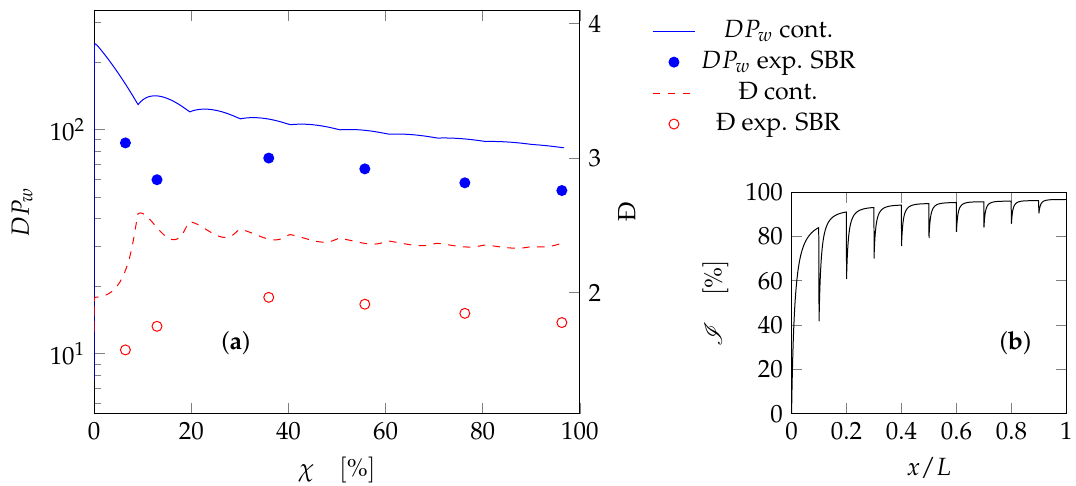
Figure 11. Series of N d = 10 PFRs with intermediate feed streams: ( a ) weight-average degree of polymerization ( DP w ) and polydispersity (Ð) as a function of the monomer overall conversion; ( b ) instantaneous conversion along the dimensionless axial coordinate. Curves: model results for the continuous reactor; symbols: experimental data for the